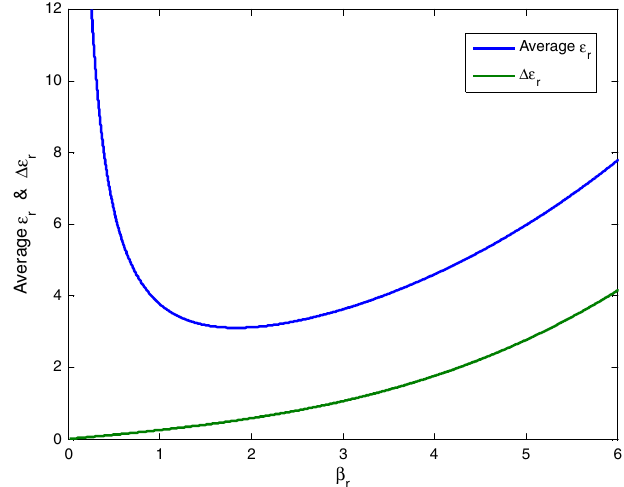
FIG. 3. Average " r and (cid:1) " r versus (cid:5) r with L B ¼ 2 m and a varying from 1 to 50 m.